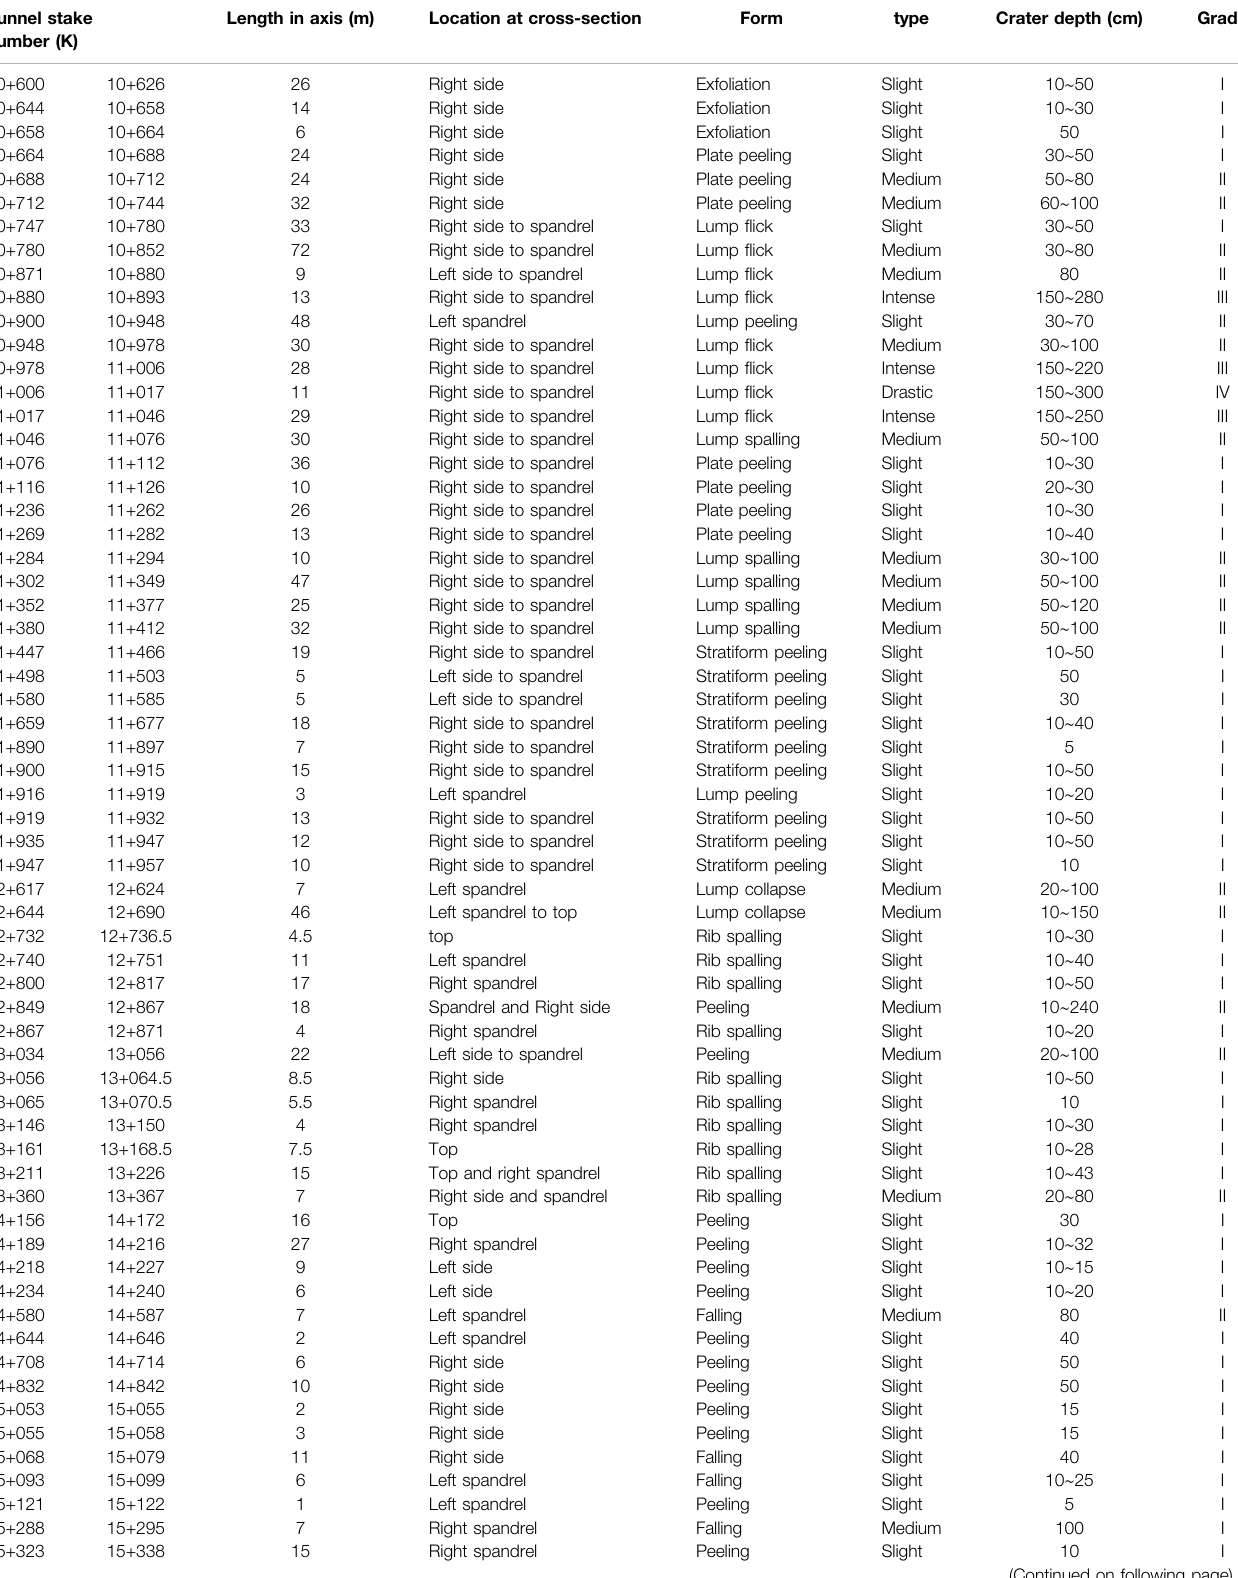
TABLE 1 | Rockbursts occurred at No. 2 diversion tunnel from stake number K10+600 to K17+000. Tunnel stake number